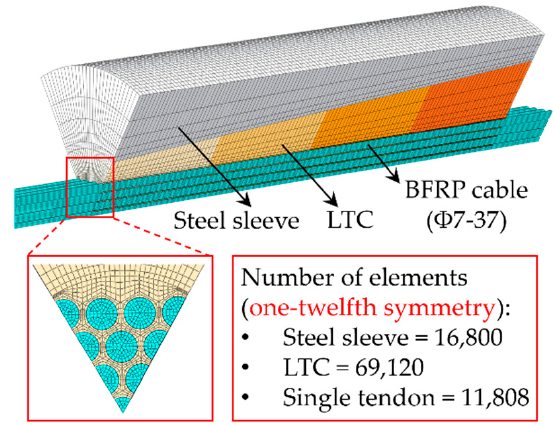
Figure 4. Full FE Figure 4. Full FE model.